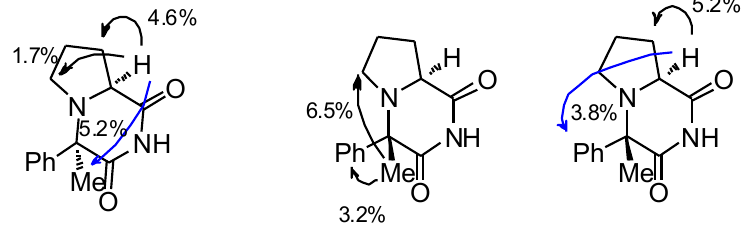
Figure 3. Selected nuclear Overhauser effect (nOe) correlations in (4 R ,8a S )-3h (left) and (4 S ,8a S )-3h (middle,